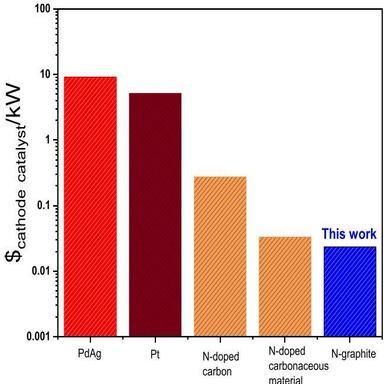
Cost comparison of PGM cathode catalysts reported in literature PdAg , Pt/C, N-doped carbo, and N-doped carbonaceous material to this work. It is worthwhile mentioning that, for two N-doped materials from the literature we have used the cost of carbon as given in Table S14.